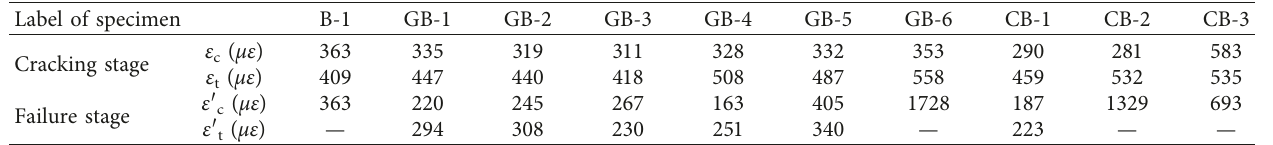
Table 10: Strain value of midspan top and bottom of the